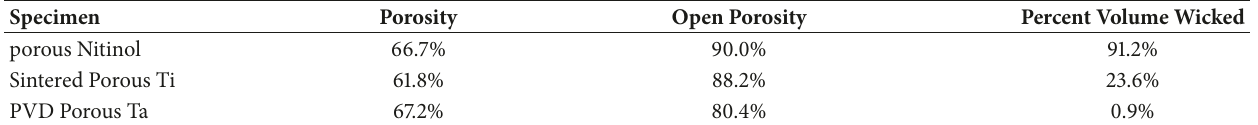
Table 3: Wicking characteristics of porous material after a 10-minute immersion.